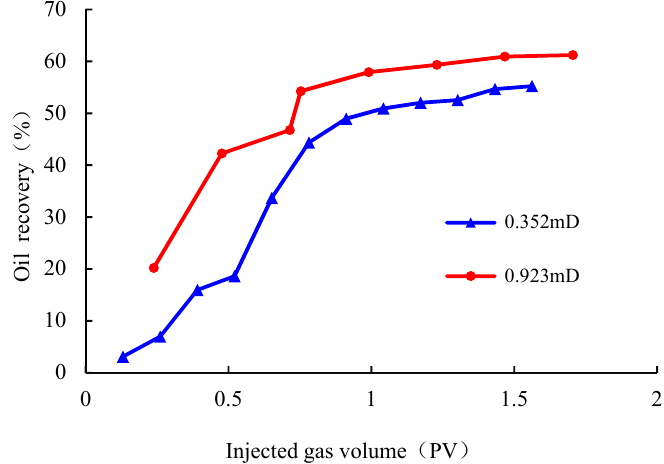
Figure 5. Relationship between CO 2 injection and recovery at different core permeability.